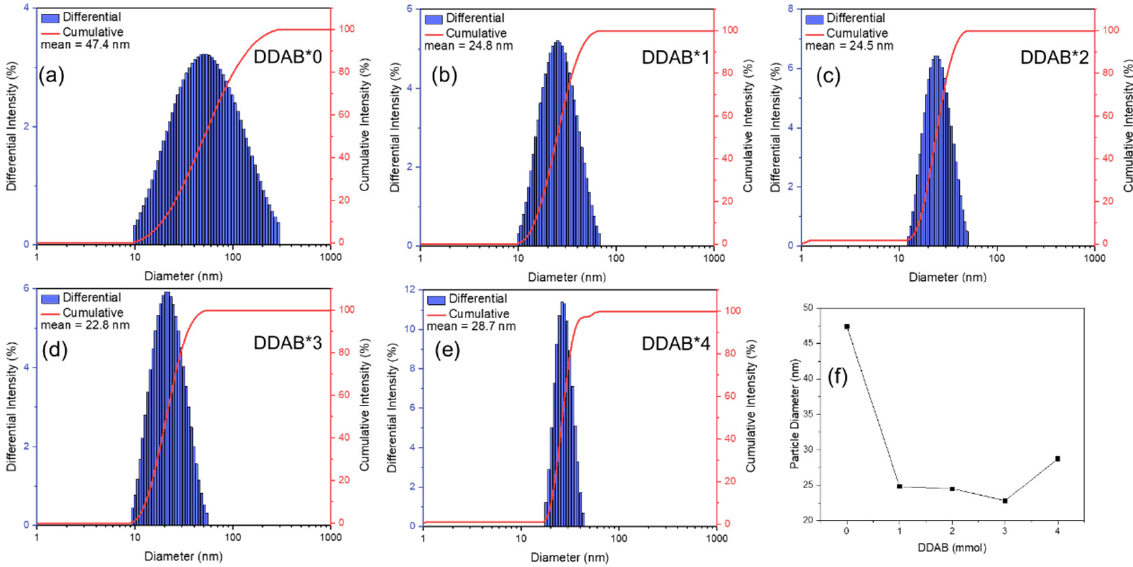
Figure 3. The diameter distribution of CsPbCl x Br 3−x PQDs treated by ( a )DDAB*0, ( b )DDAB*1, ( c )DDAB*2, ( d )DDAB*3, and ( e )DDAB*4. ( f ) The mean diameters of PQDs with different DDAB concentrations.